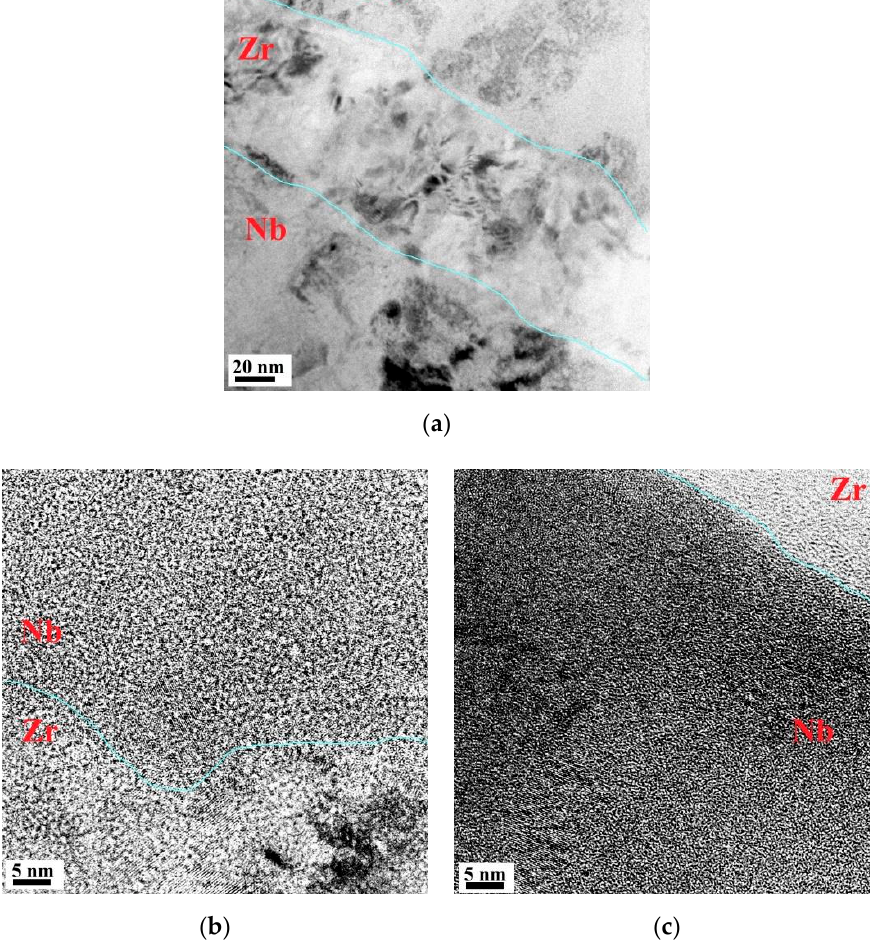
Figure 5. Cross-sectional HRTEM images of the Zr/Nb multilayer ( a ) bright-field image of the Zr/Nb multilayers ( b ) corresponding fast Fourier transform (FFT) for the HRTEM images of the Zr/Nb ( c ) and the Nb/Zr interfaces. The blue lines show the interface between Zr and Nb.